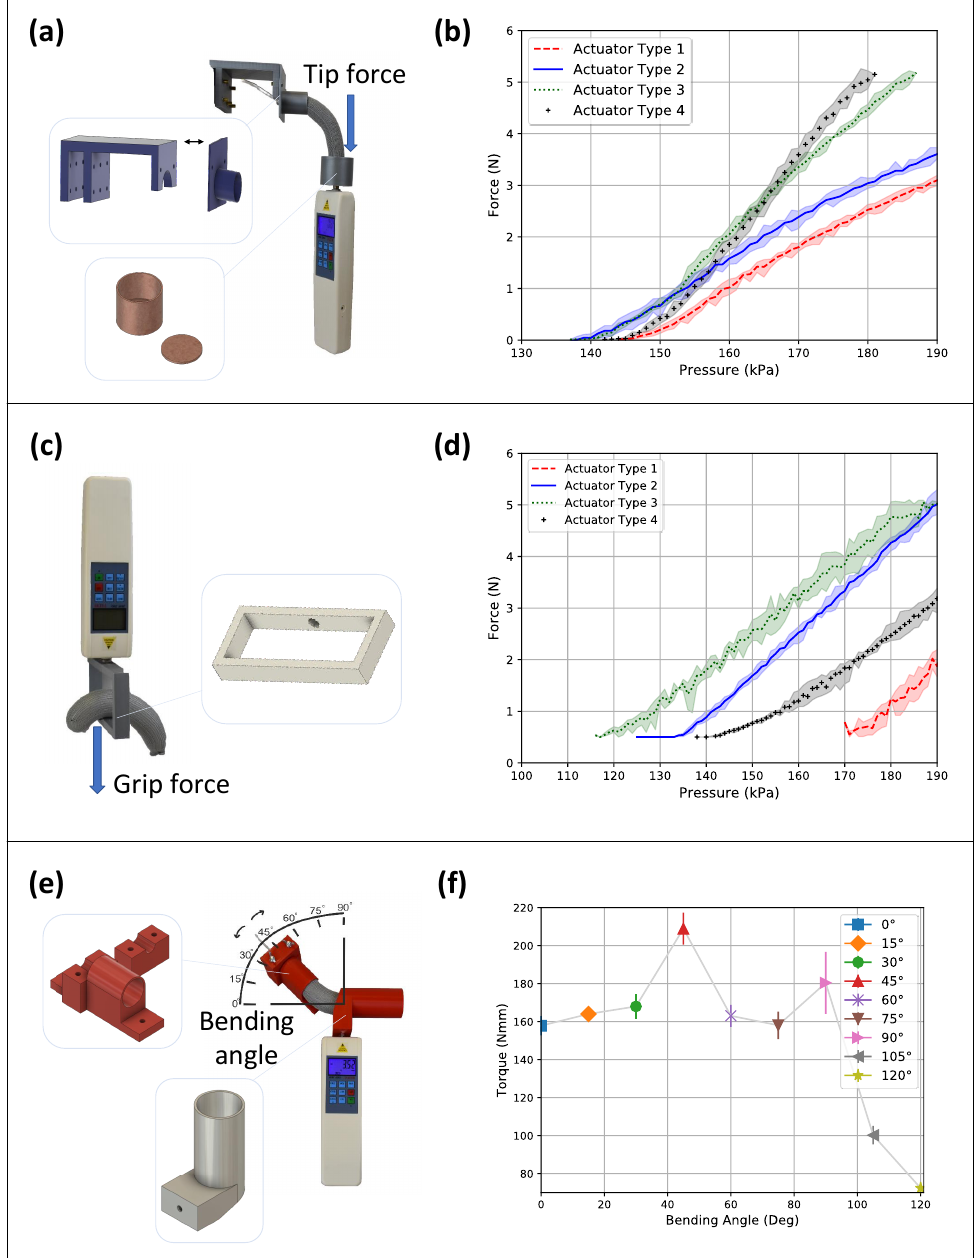
Figure 3. ( a ) Tip force test setup. ( b ) Tip force-pressure characteristics of all actuators. ( c ) Grip force test setup. ( d ) Grip force-pressure characteristics of all actuators. ( e ) Torque test setup. ( f ) Output torque of Actuator Type 3 at different bending